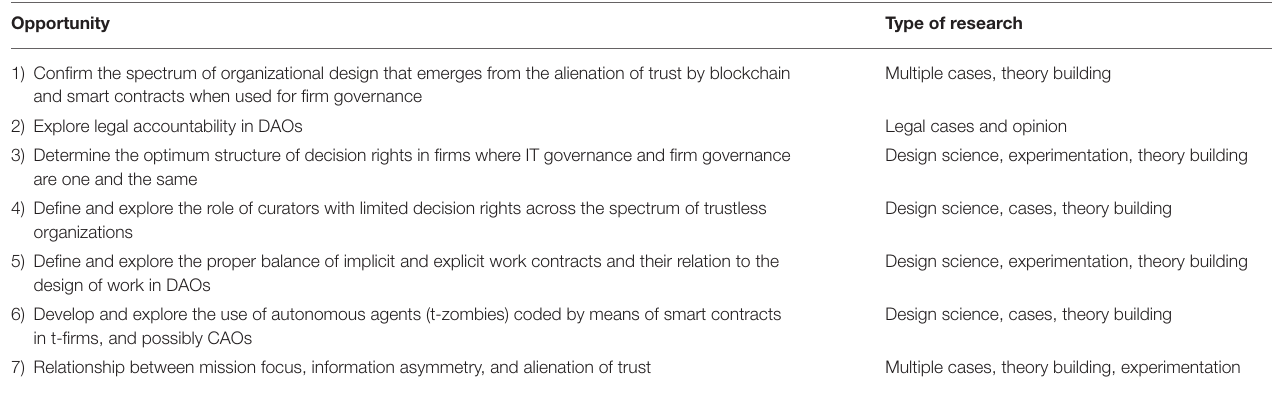
TABLE 1 | Summary of opportunities for future research, and type of research.